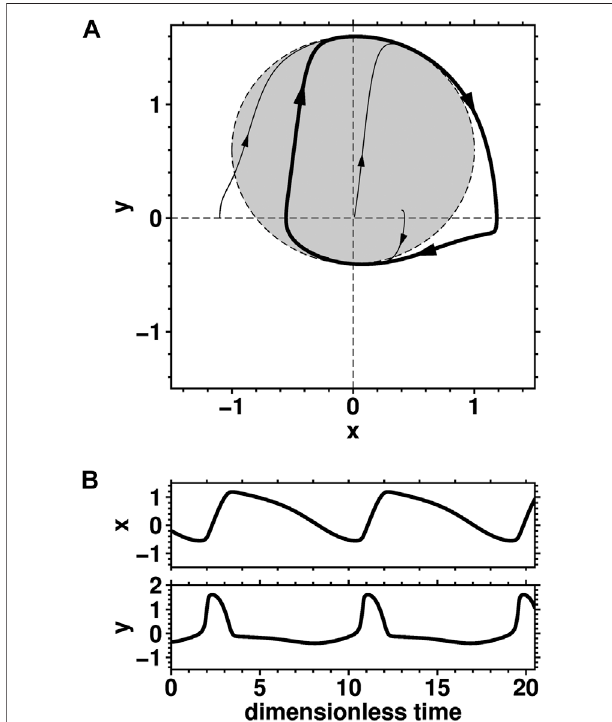
FIGURE6| Nonlinearoscillationoftheidealizedmodelgovernedby Eqs 5a , 5b , for μ = 10 and y 0 = − 0.6. (A) : Phase portrait in the ( x , y )-plane, with y (cid:1) _ x ; (B,C) : The associated time series representing, respectively, x ( t ) and y ( t ). In (A) , the closed trajectory (heavy solid line) is the limit cycle. The light solid lines are typical trajectories converging to the limit cycle from the interior and the exterior of this cycle. The shaded area is the one where dampingisnegative,i.e., κ > 0in Eq.7 .Arrowsindicatethedirectionofmotion on the limit cycle and on the trajectories that converge onto it.